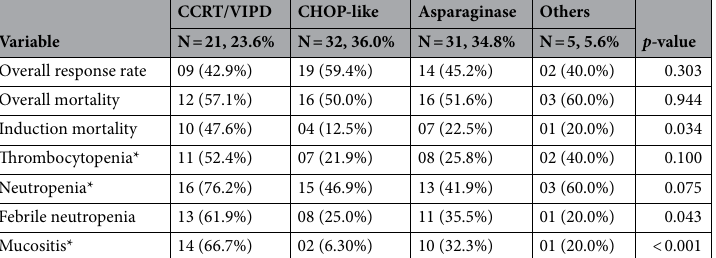
Table 3. Up-front therapy modalities, responses e toxicities for 89 ENKTCL Brazilian patients. *The toxicities displayed were considered for grades 3 or 4 according to CTCAE version 4.0.